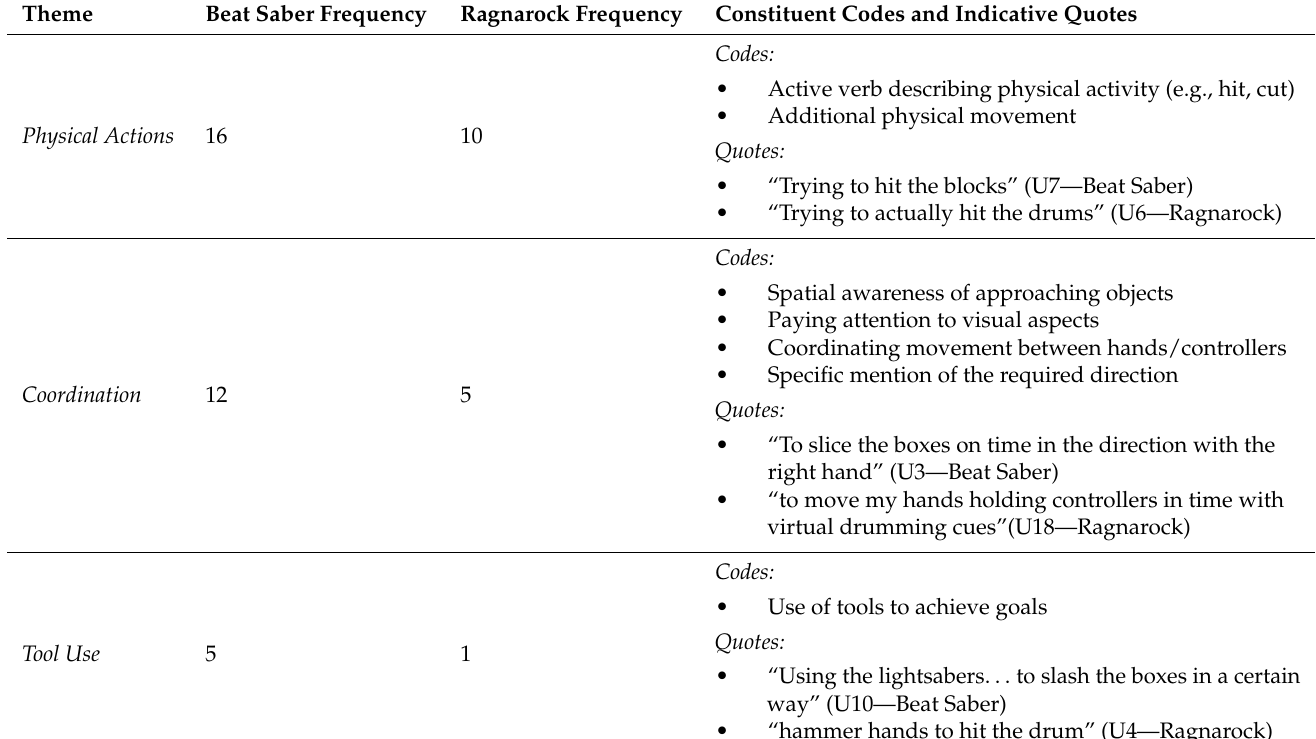
Table 4. Frequency of themes per game relating to users’ objectives, with illustrative